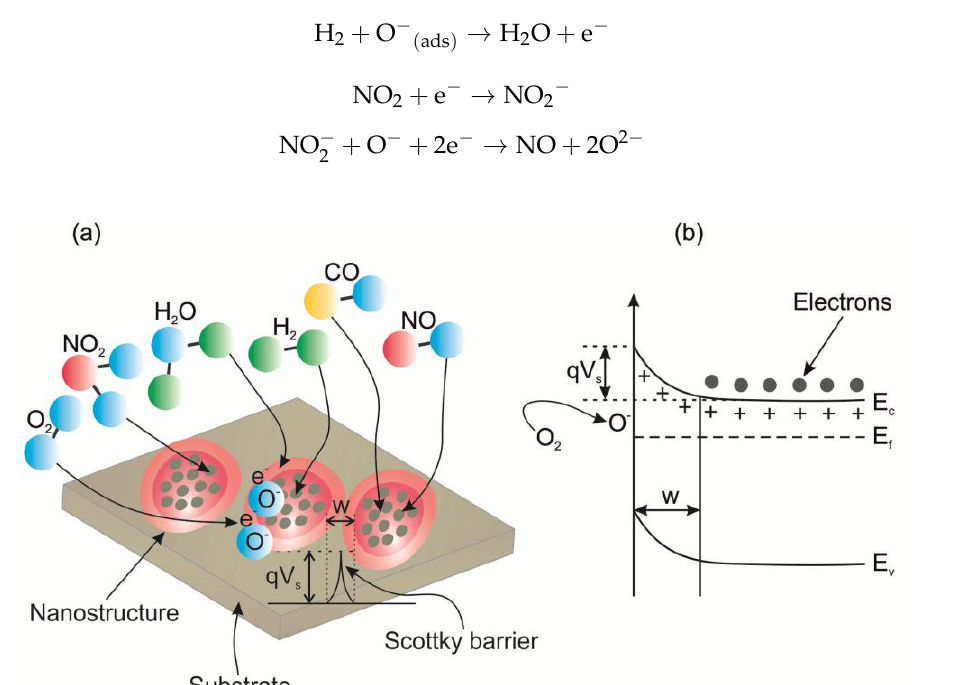
Figure 10. ( a ) The structural and the band model of oxide material showing the role of pores contact regions in determining the conductance over the TiO 2 due to the adsorption/desorption process of oxidizing and reducing gases. ( b ) The model illustrating the band bending in the metal oxide material due to the ionosorption of oxygen on the material surface. E C , E V , and E F denote the energy of the conduction band, valence band, and the Fermi level, respectively.